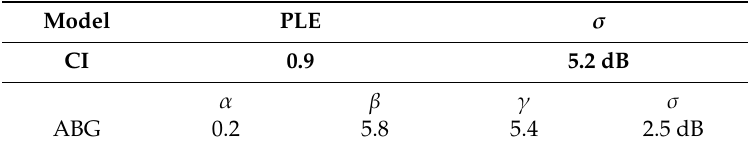
Table 2. Multilateral path loss models 19, 28, and 38 GHz; CI; and alpha–beta–gamma (ABG) model